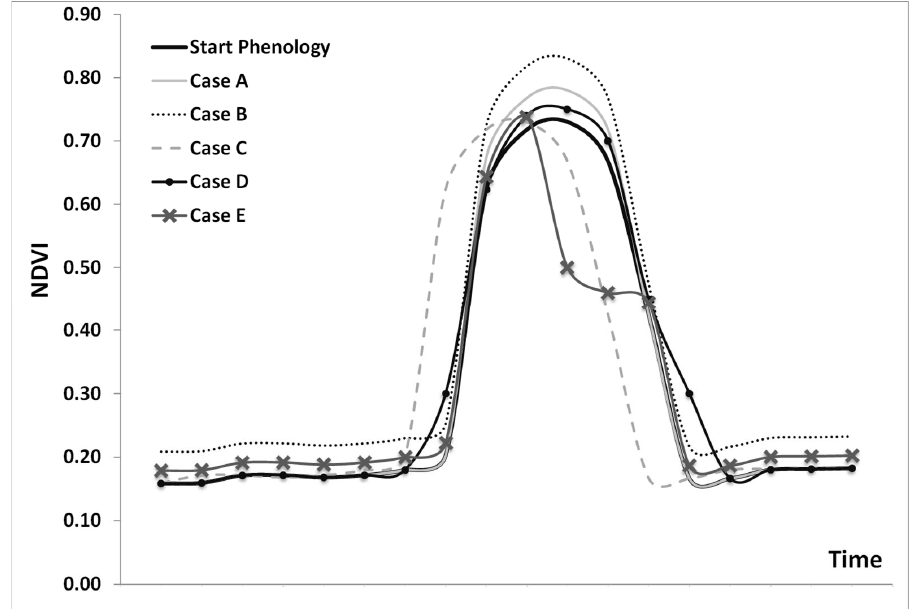
Figure A1. Phenological profiles under different conditions [5,77]. Case A: Change in the amplitude of the NDVI Phenological Curve in an area which is moisture constrained; a trend of increasing rainfall may result in an increase in peak greenness relative to the greenness out of the growing season (or the opposite which leads to a decrease of the peak greenness). Case B: Overall change of the greenness (NDVI) throughout the year for example in an area with similar (not the same) crop cultivation. Case C: Shift in the time of the peak in an area where changes in the temperature and/or rainfall regimes lead to a shift in the phenophase associated with growth, maturation and death. Case D: Lengthening of the growing season yielding a broader or narrower phenological trajectory through time as can occur with rising or falling temperatures in areas that are temperature constrained and lastly, Case E: Change in the shape of the phenological curve, during the phenological cycle in areas after the invasion of species or due to changes in the rainfall regime. On the other hand, this is also the case when the crop is characterized under stress due to the lack of soil nutrients. The latest might be related to buried archaeological remains such as walls (negative crop marks) ([5]).